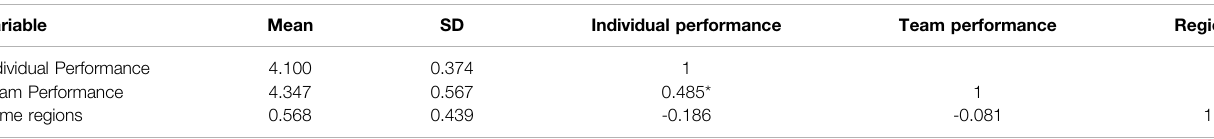
TABLE 4 | Analysis of the correlation between student satisfaction and